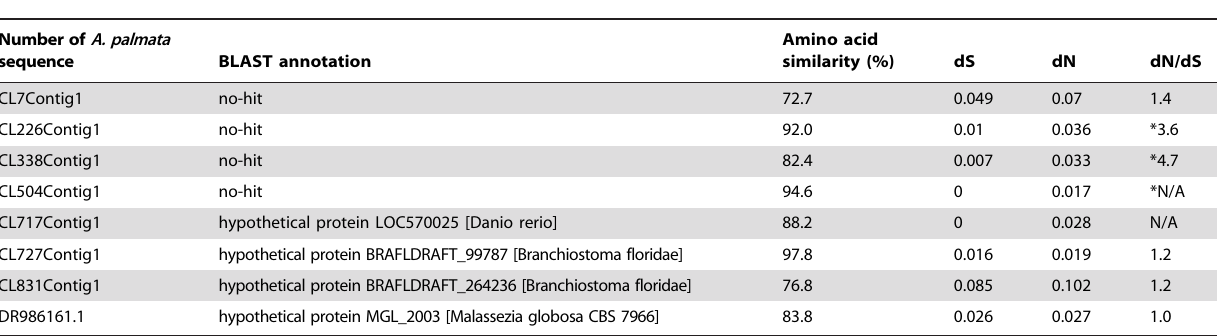
Table 2. Positive selection candidates of Acropora .